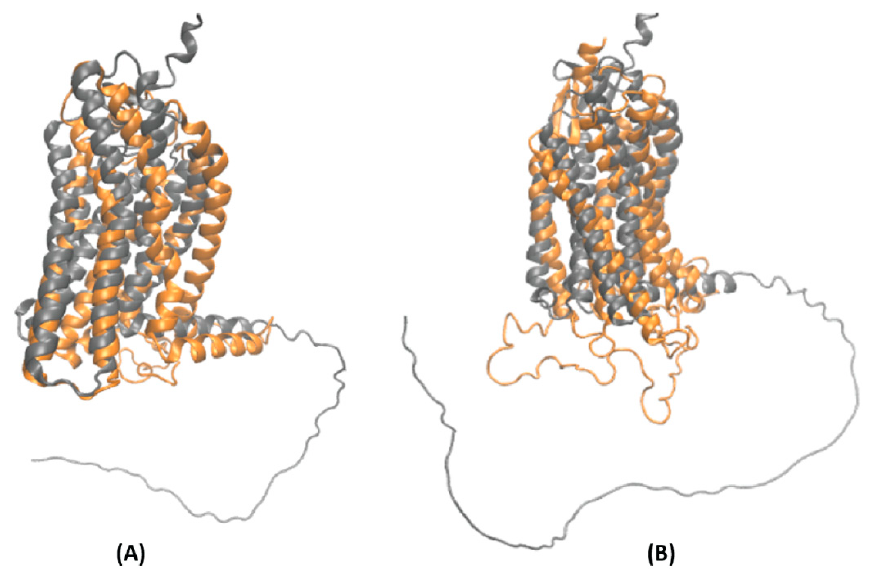
Figure 6. Secondary structure of GPCRs obtained from GPCR-I-TASSER server (orange) and Al- phaFold2 database (gray), ( A ) GPR109A/HCAR2 structure ( B ) GPR109B/HCAR3 structure.